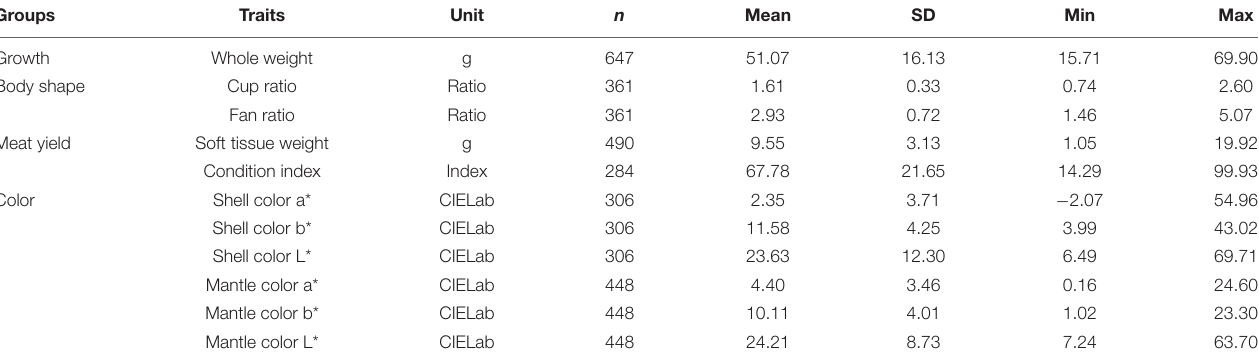
TABLE 1 | Summary of the phenotypic data.